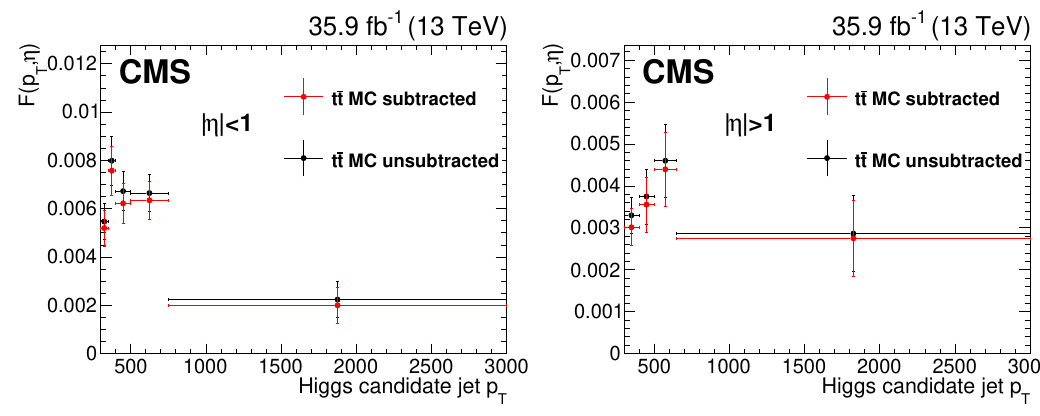
Figure 4 . Transfer function F ( p T ; (cid:17) ) used for estimation of the QCD background in the signal region, shown in the central (left) and forward (right) (cid:17) regions. The error bars represent the statistical uncertainty in F ( p T ; (cid:17) )